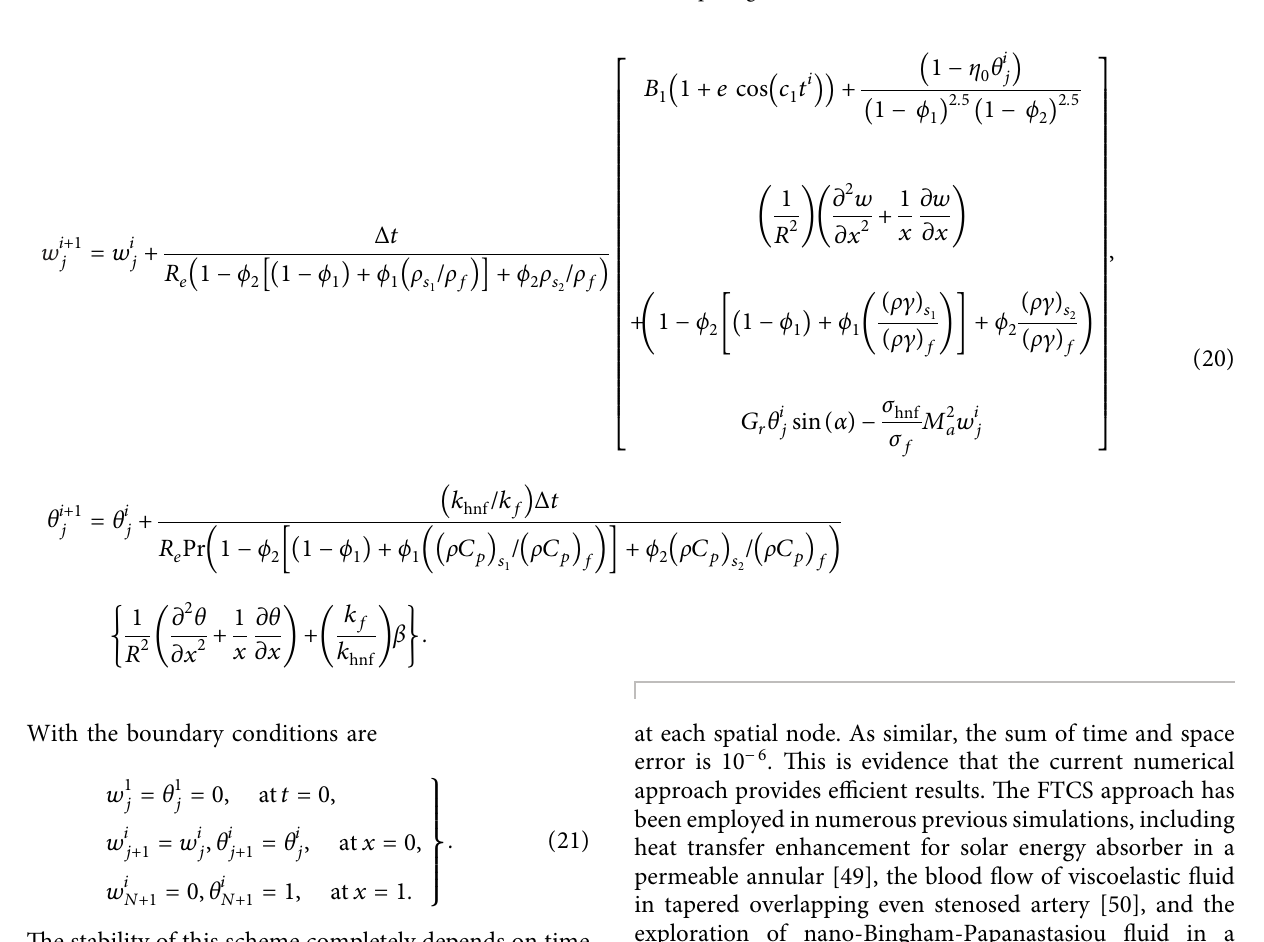
Figure 2: Finite difference space